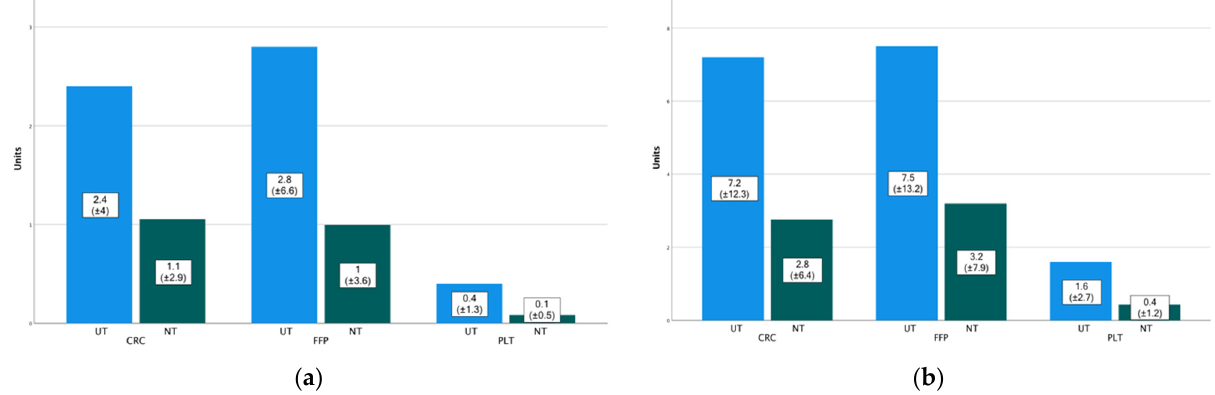
Figure 5. Bar diagram comparing the need for concentrated red cells, fresh frozen plasma and platelet concentrates between UT and NT within the first 3 h ( a ) and 24 h ( b ) after admission.